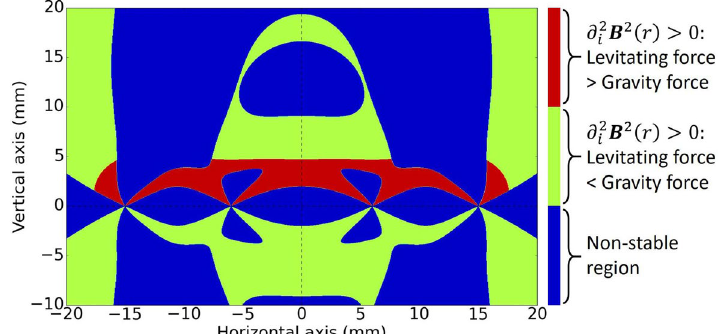
Figure 2. Stability/instability regions and critical line in a vertical cross section plane. Blue represents the unstable region, while red and green represent regions where the second derivative of the energy is greater than zero. The boundary between red and green regions is the zero force line, i.e the levitating